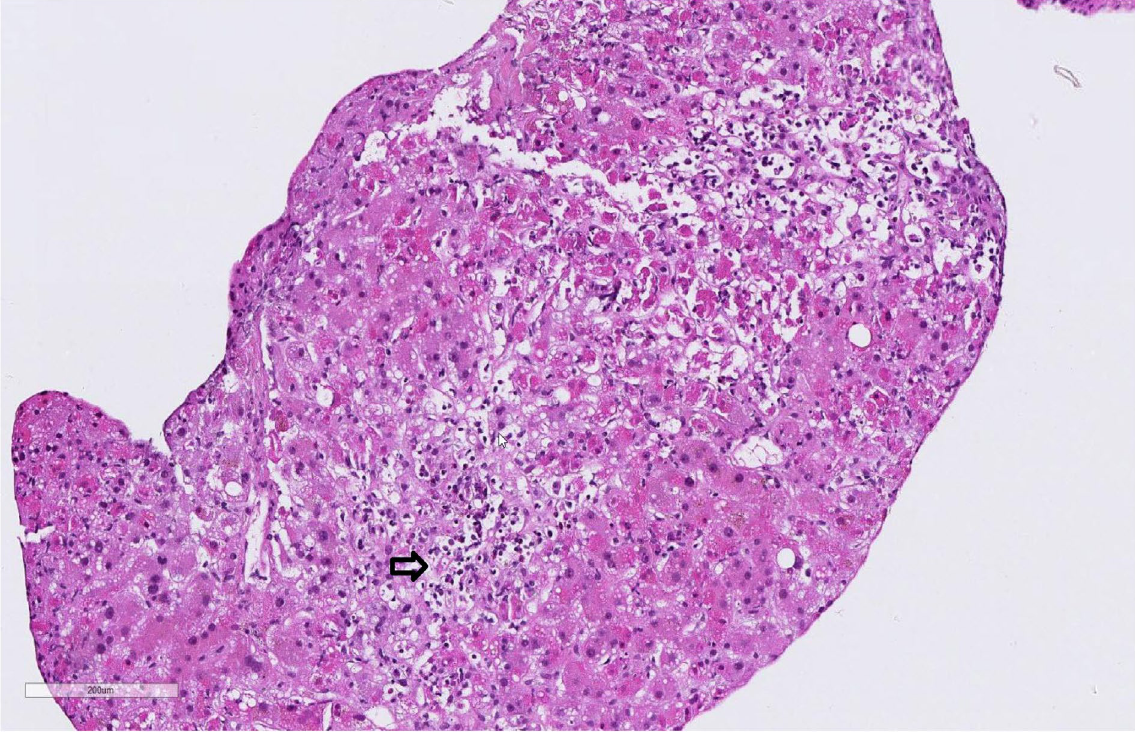
Figure 2. Case 2 liver biopsy: portal fields has expanded, due to a mixed cell infiltrate dominated by lymphocytes and eosinophils. Extensive interface lesions. Bile duct alterations and florid endothelial changes (arrow, hematoxylin-eosin,